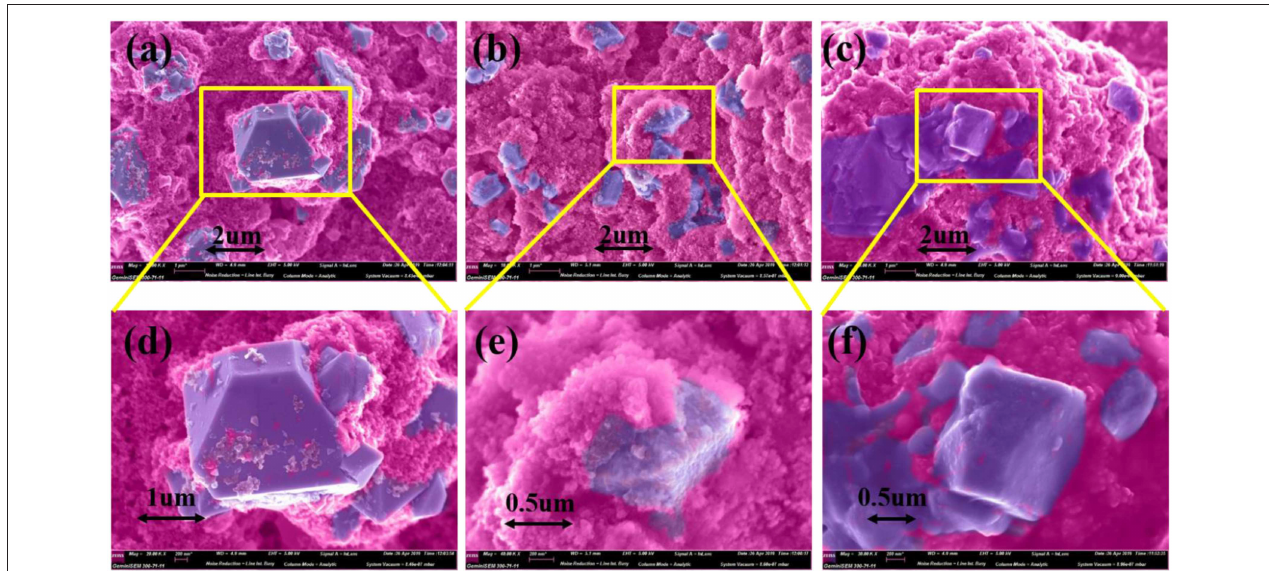
FIGURE 4 | SEM images of LNMO electrodes with different electrolytes after 40 cycles: (a,d) fresh, (b,e) with no additive, and (c,f) with 0.5 wt.% PTSI.